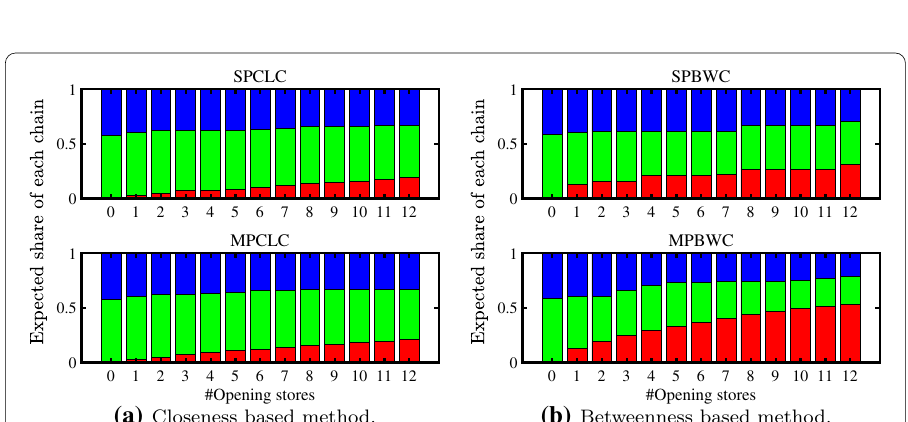
Fig. 6 Expected share of each group after opening stores of g1 and their breakdown (Naha): Each bar shows the expected number of covered nodes and their breakdown (g1: red, g2: green, and g3: blue) when stores of the g1 group are opened one by one at the nodes extracted by each